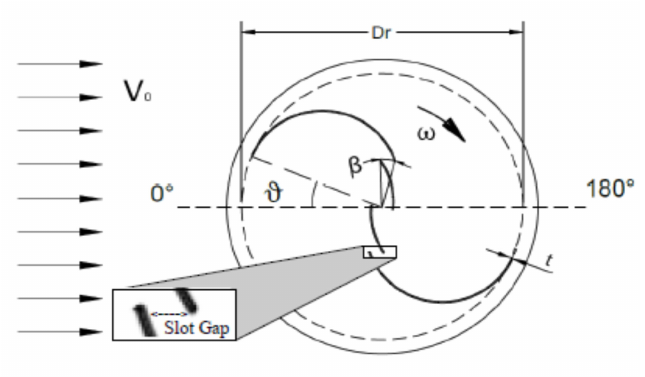
Figure 13. The slotted rotor model analyzed